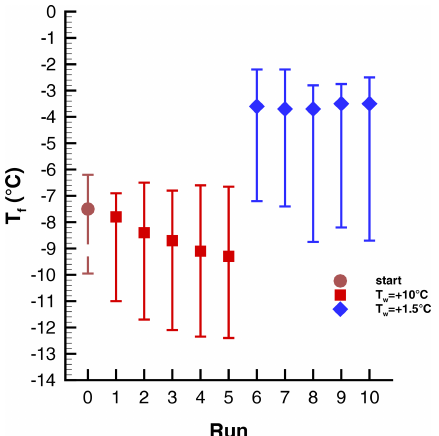
Figure 13. Range of freezing temperatures in Exp. I consisting of a sequence of runs with high and low warm limits. The 50th percentile is indicated by symbols and the vertical lines show the 10th- and 90th-percentile